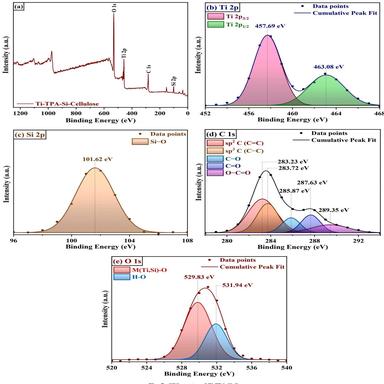
XPS spectra of Ti-TPA-Si-C.